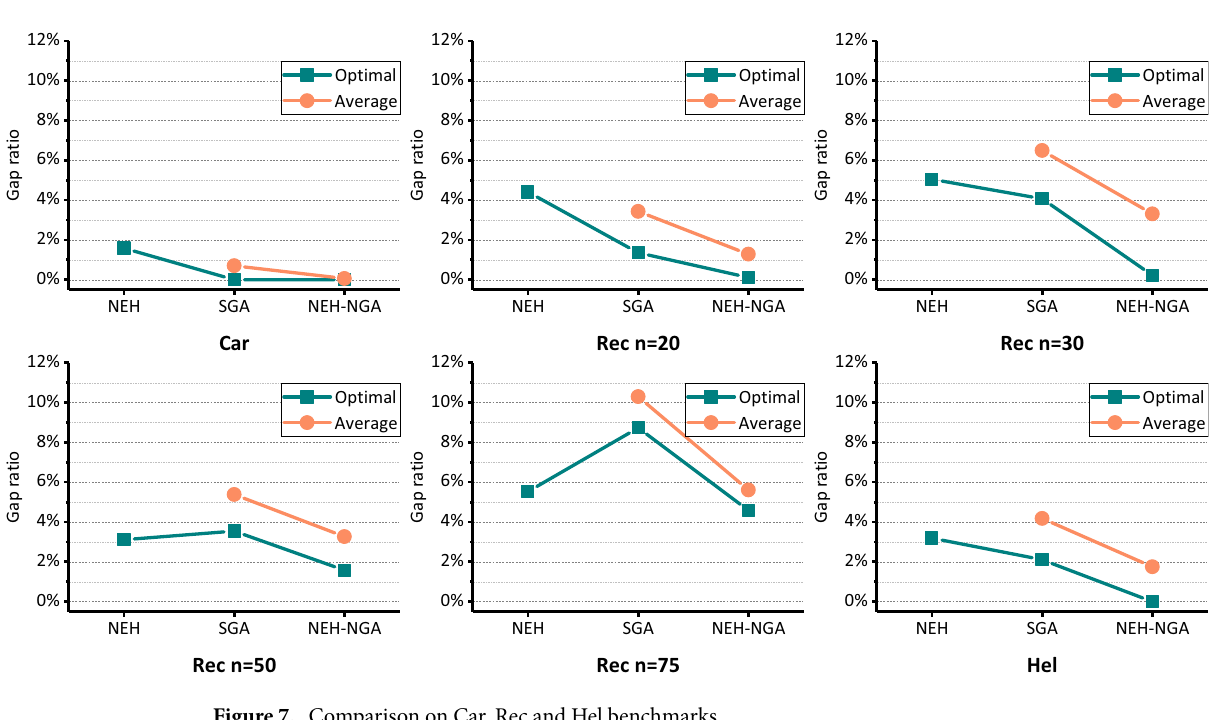
Table 3. Solutions on taillard benchmarks.